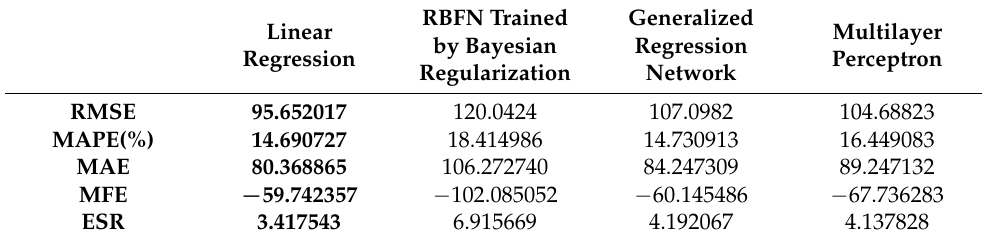
Table 4. Prediction results of ANNs models.